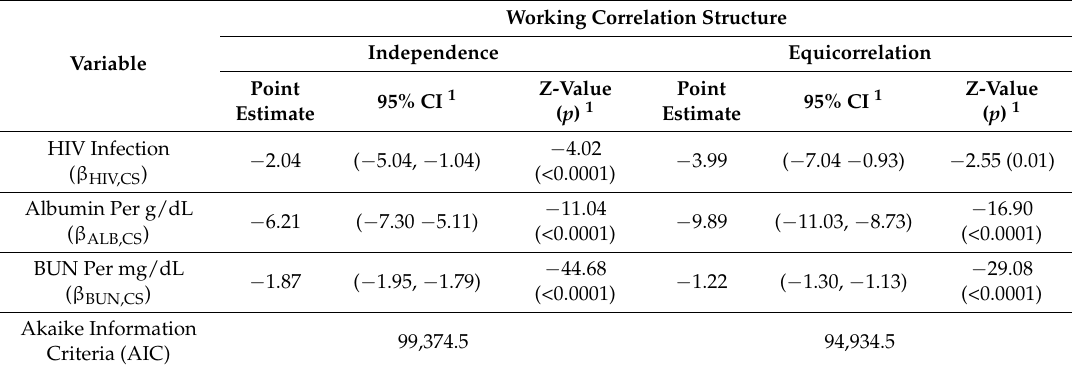
Table A1. Parameter estimates for the cross-sectional regression of Table 1 EGFR = HIV infection, serum albumin and BUN in the Bronx WIHS using mixed models.